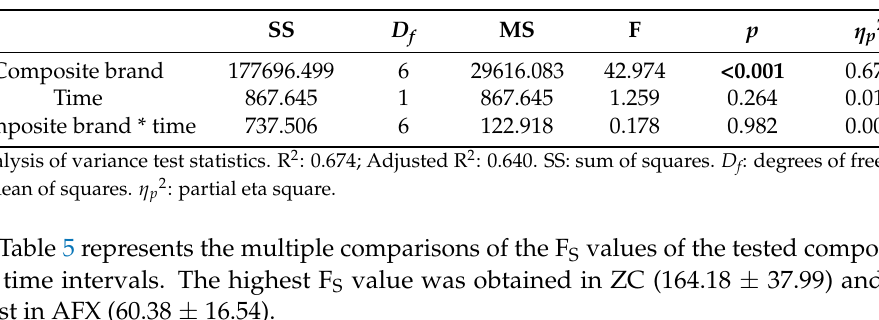
Table 4. Comparison of F S values according to composite brands and time.